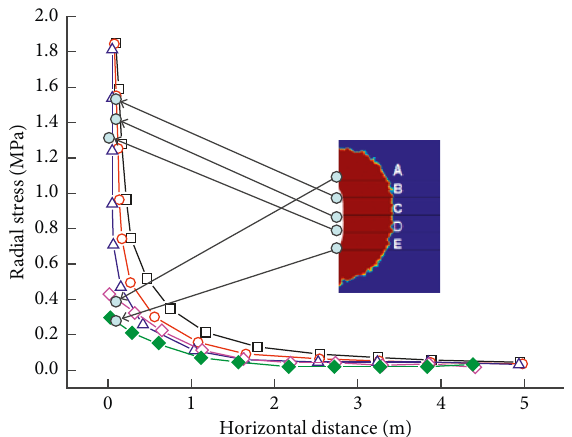
Figure 7: Radial stress distribution curves at different heights.